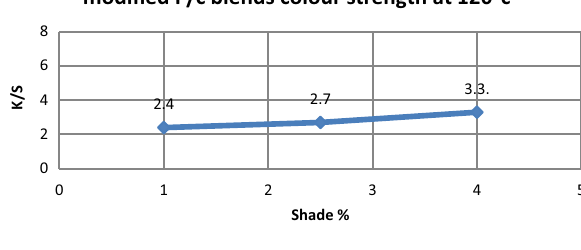
Fig. 8 K/S value of modi- fied P/c blends dyed using disperse dye in one bath at 120